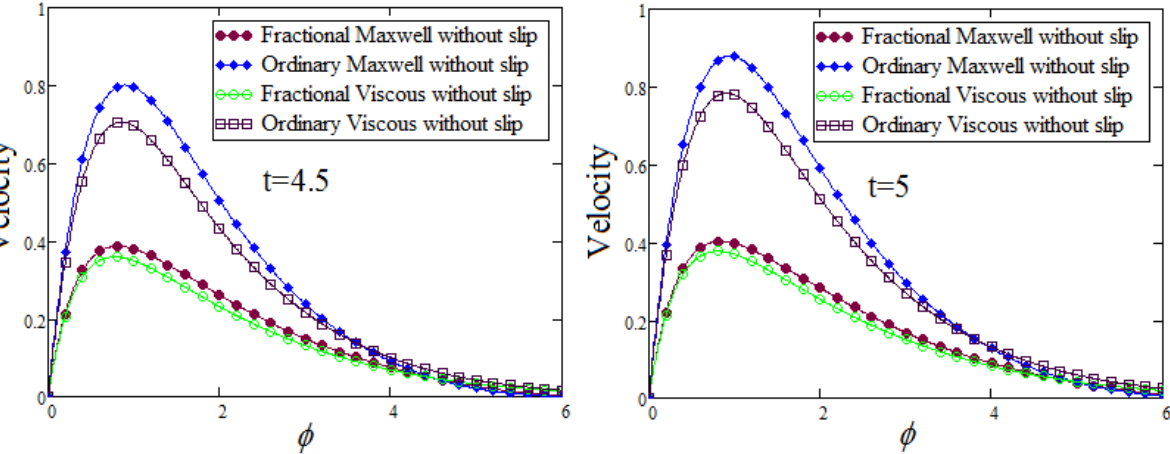
Figure 18. Comparison of velocity profile for the fractional viscous, fractional Maxwell, classical viscous and classical Maxwell fluids in the presence of no slip conditions at two different levels of time, when Pr = 12, Gr = 5, Gm = 3.5, ω = 0, ℘ = 0.4, Sc = 9, α = 0.5 β = 0.3, and γ =